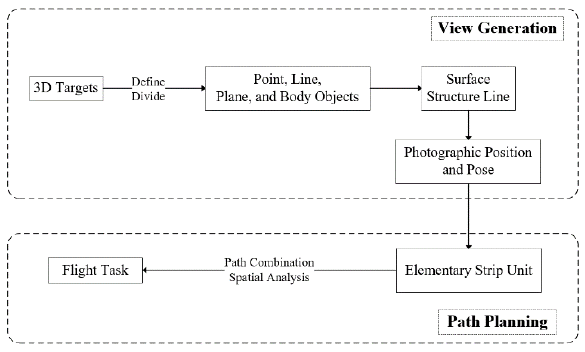
Figure 1 . The overall pipeline of the proposed